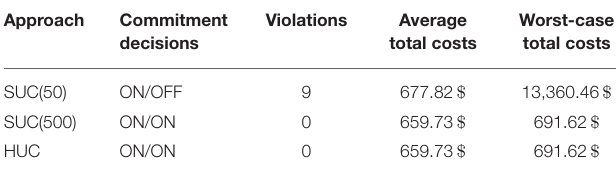
TABLE 2 | Comparison between SUC and